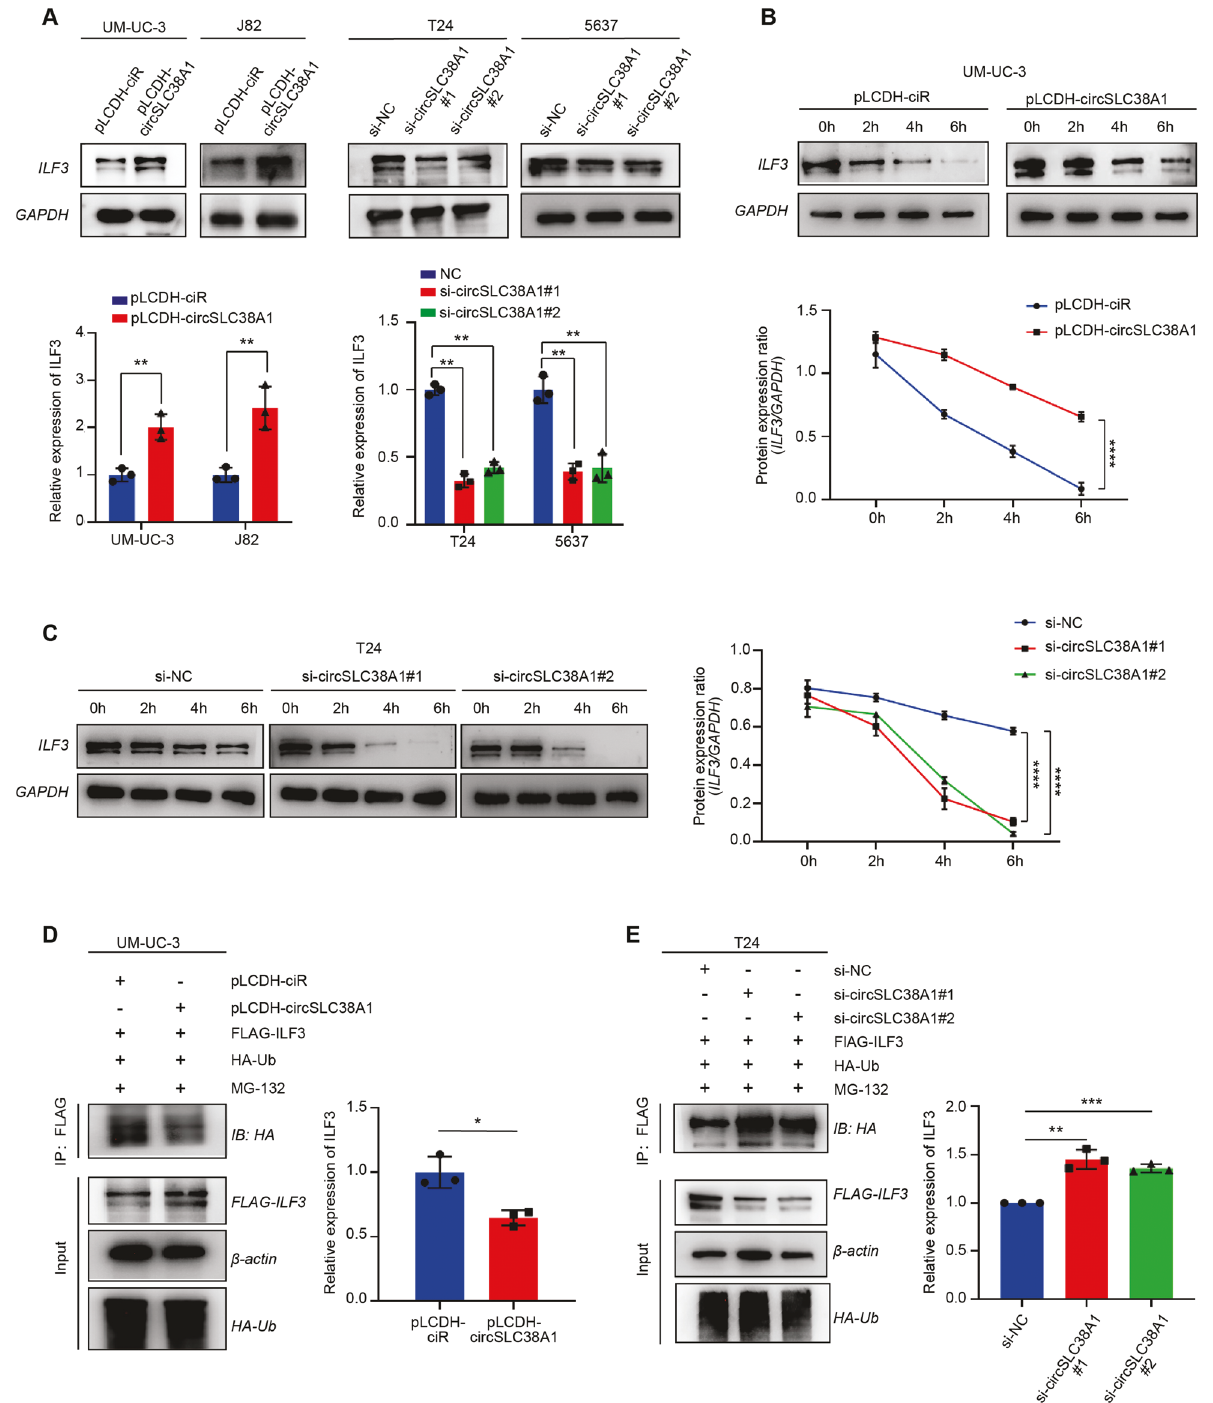
Fig. 6 circSLC38A1 increased ILF3 expression via inhibition of protein degradation. A Expression levels of ILF3 in BC cells with circSLC38A1 de fi cient or circSLC38A1 overexpression. B Protein level of ILF3 in UM-UC-3 cells over-expressed circSLC38A1, followed by 100 µg/ml CHX treatment for the indicated time points. C Protein level of ILF3 in circSLC38A1 knockdown T24 cells, followed by 100 µg/ml CHX treatment for the indicated time points. D , E Immunoblot analysis of ILF3 in polyubiquitination assays of 293 T cells transfected with the indicated constructs and treated with 20 µM MG132 for 6 h. Data represent mean ± SD from three independent experiments; * P < 0.05, ** P < 0.01, *** P < 0.001, **** P < 0.0001. well-reported oncogene involved in tumor metastasis [15], and we (Fig. S5e). Furthermore, sixteen genes can be enriched by GO found that the expression level of TGF- β 2 increased with tumor analysis and transforming growth factor beta-2 (TGF- β 2), and NOG TNM staging progress through TCGA database analysis (Fig. S5f). was chosen since they were enriched to epithelial to mesench- The IGV map clearly showed that the proximal promoter region of ymal transition (EMT) process (Table S8, Fig. 7C). TGF- β 2 was a